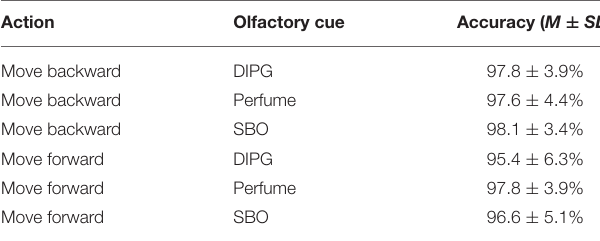
TABLE 3 | Olfactory VAAST: accuracy of participants.